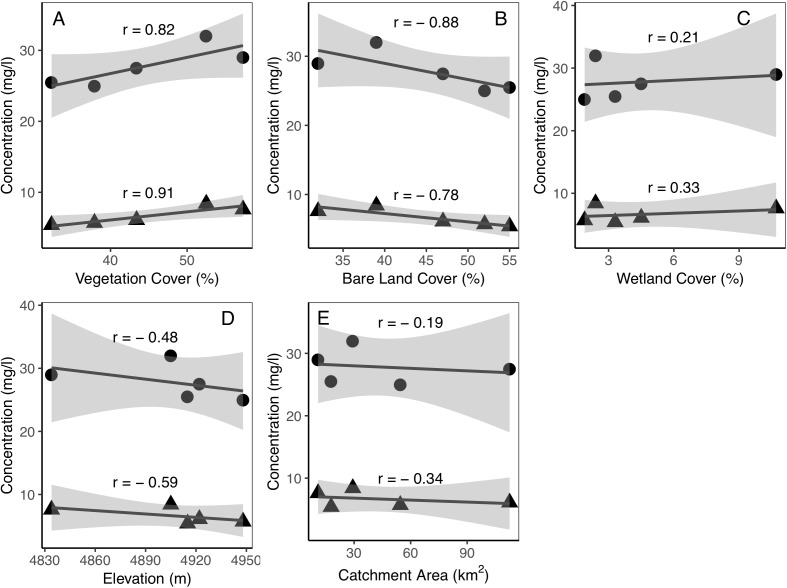
Relationships between catchment characteristics and dissolved carbon concentrations of the five catchments.(A) vegetation coverage vs. dissolved carbon concentrations; (B) bare land coverage vs. dissolved carbon concentrations; (C) wetland coverage vs. dissolved carbon concentrations; (D) mean basin elevation vs. dissolved carbon concentrations; (E) catchment area vs. dissolved carbon concentrations. The round solid dots are DIC and the triangle dots are DOC. The r is linear correlation coefficient. The shaded regions in the graphics are 95% confidence interval.